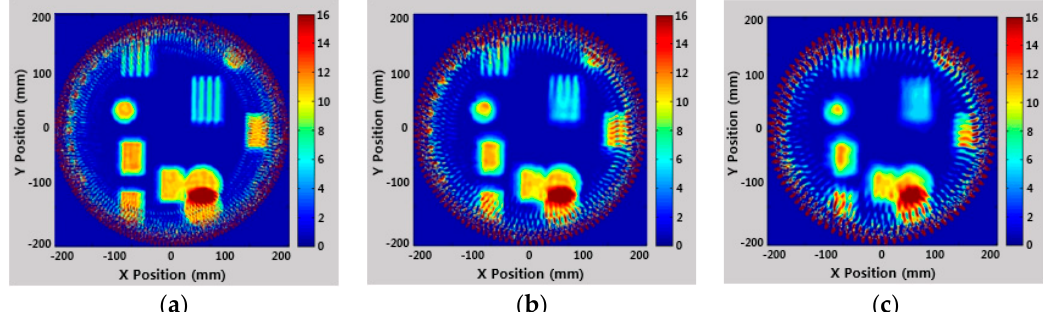
Figure 3. Guided wave signal: ( a ) No defect signal; ( b ) Defect signal.